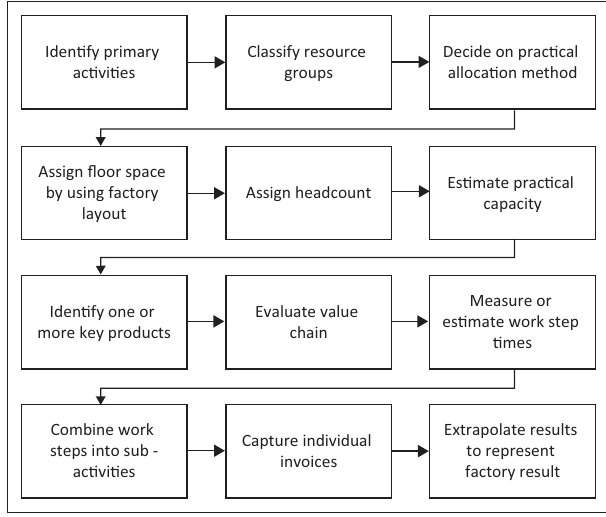
FIGURE 3: Proposed modified framework for time-driven activity-based costing implementation at small and medium